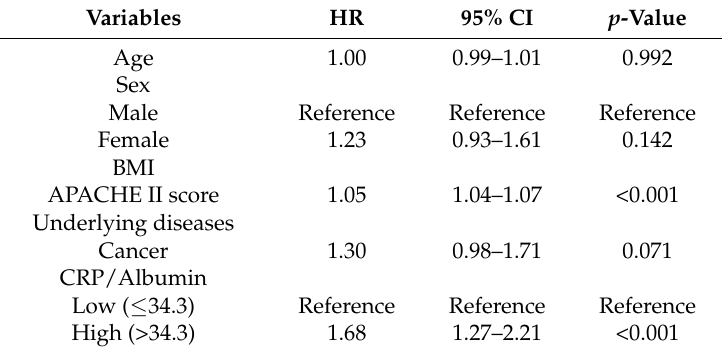
Table 3. Cox proportional hazard regression analysis for 28-day